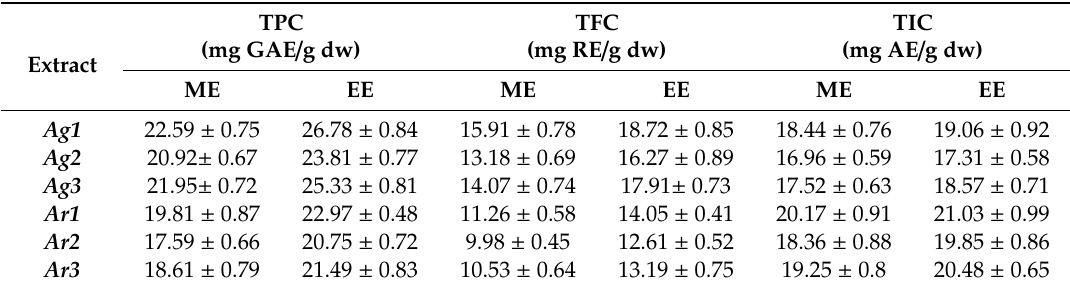
Table 1. Total phenolic content (TPC), total flavonoid content (TFC) and total iridoid content (TIC) in A. genevensis ( Ag1, Ag2, Ag3 ) and A. reptans ( Ar1, Ar2, Ar3 ) extracts ( ±